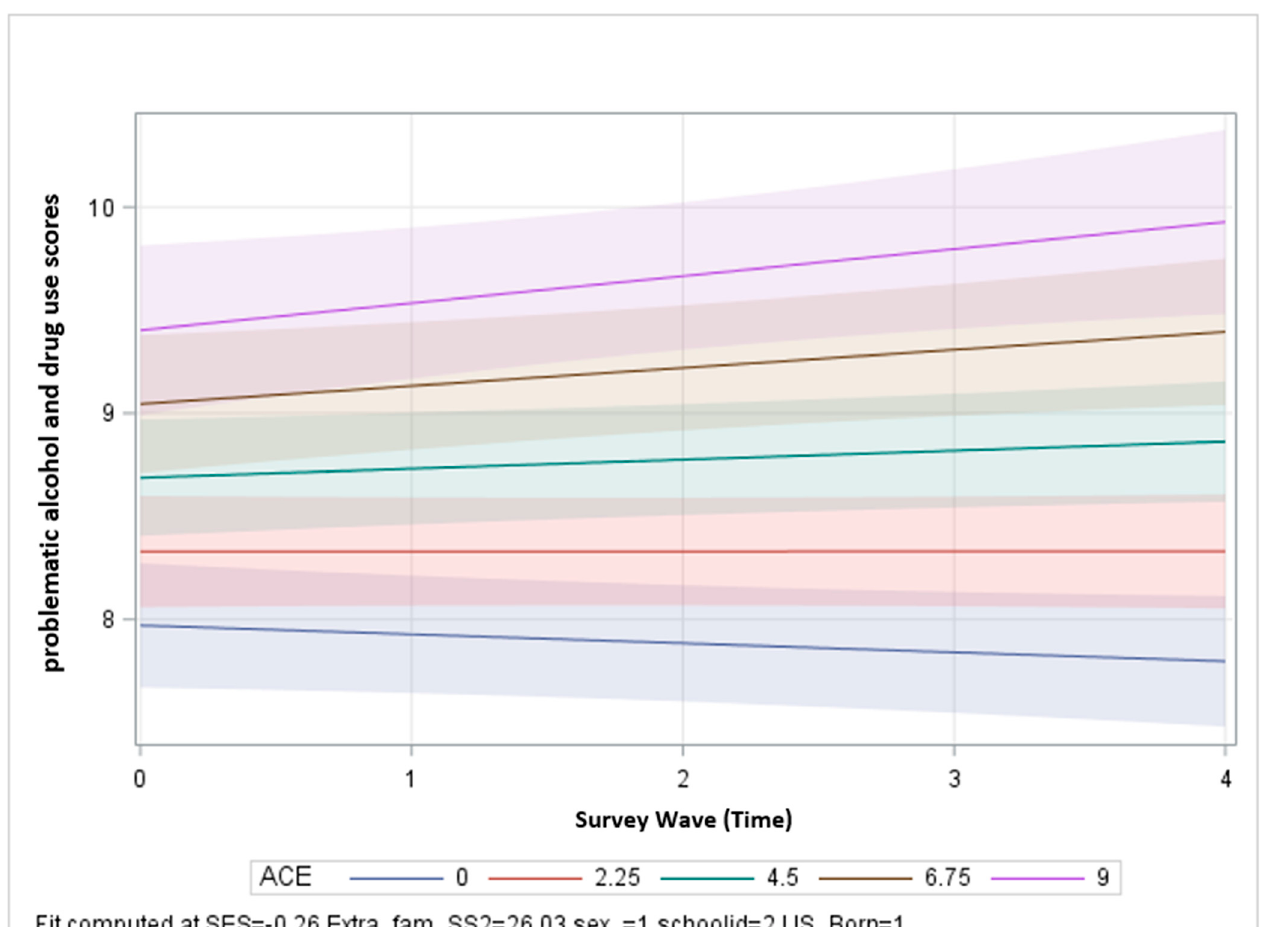
Figure 1. Problematic alcohol and drug use scores over time by level of ACE exposure, controlling for covariates.